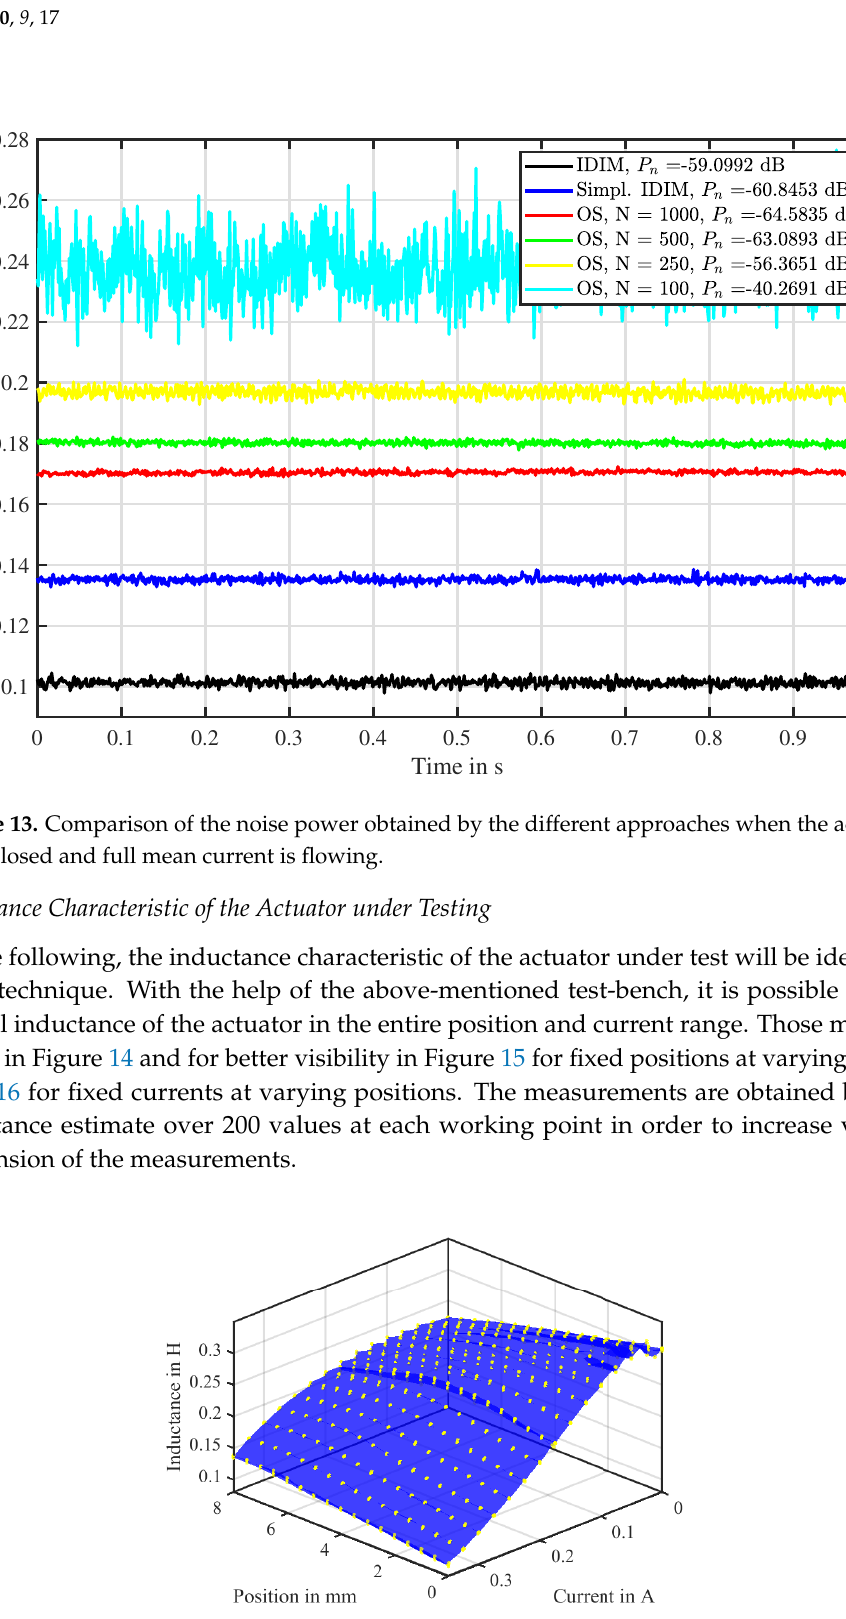
Figure 14. Obtained inductance characteristic when the IDIM approach is used. Inductance characteristic is shown over the entire position and current range. The yellow dots indicate the measured data points while the blue surface illustrates the interpolated